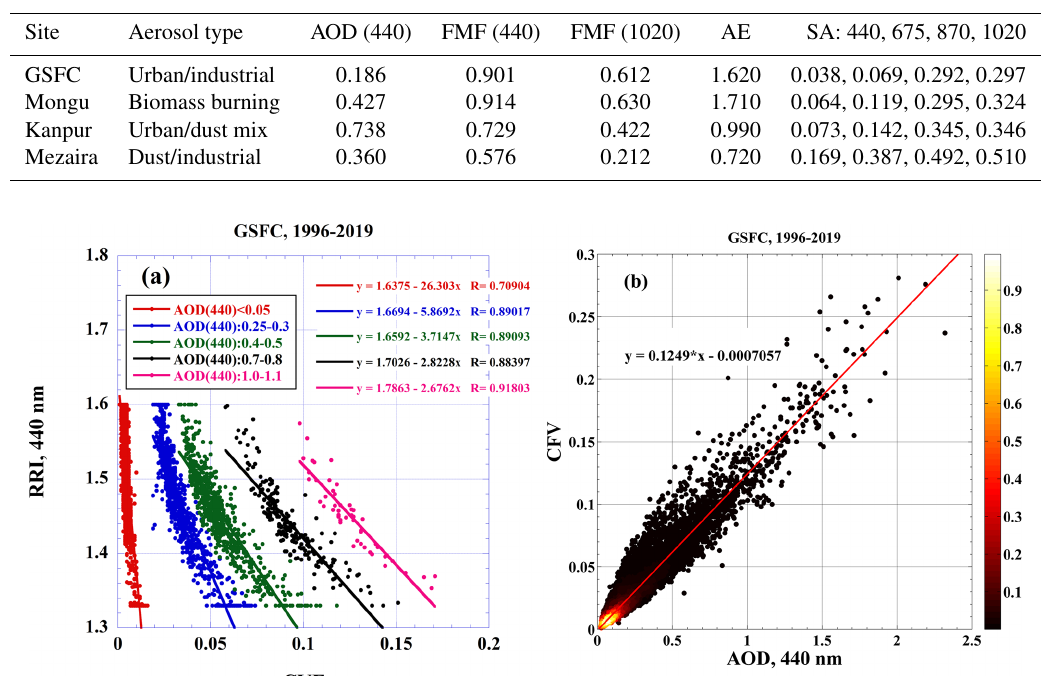
Figure 25. Analysis of correlation between the real part of the refractive index and fine-mode concentration at the GSFC